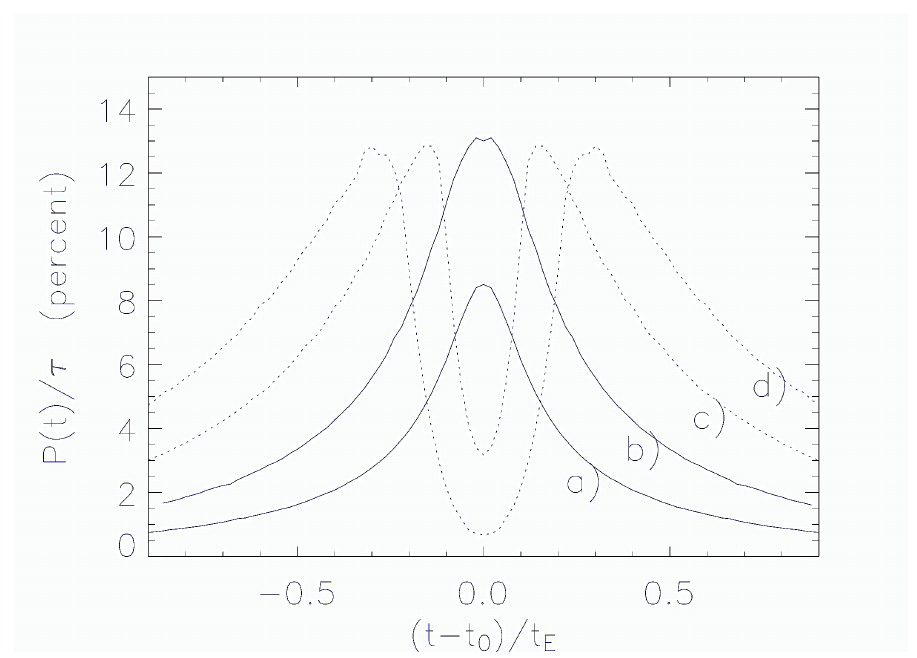
Figure 6. Assuming parameter values u 0 = 0.09, t E = 60 day and R h / R S = 5, the P ( t ) / τ polarization curves are shown as a function of ( t − t 0 ) / t E , for increasing values of R h / u 0 = 0.35, 0.75, 1.5, 2.5, corresponding to the curves labeled (a), (b) (c) and (d), respectively. Continuous curves, (a) and (b), are bypass events; dotted lines, (c) and (d), are transit events. Here, R h is the minimum distance for the formation of dust grains, and R S is the source star